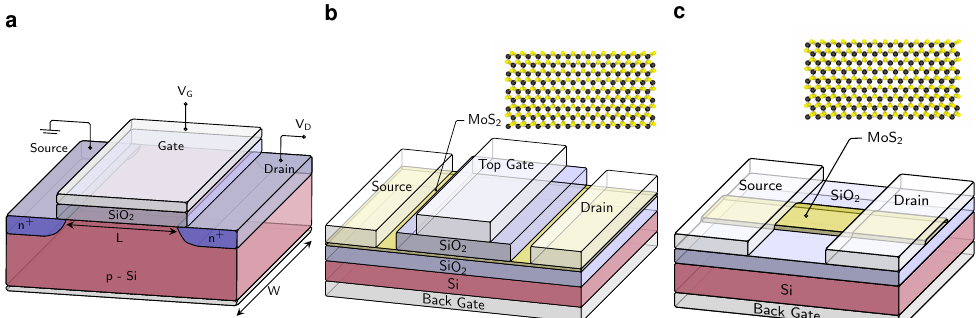
Figure 1. ( a ) Schematic drawing of a planar n-type silicon MOSFET. ( b ) Schematic layout of a large area FET with an MoS 2 channel. Here, SiO 2 is the back gate oxide with Si serving as the global back gate and the top gate oxide with a local top gate contact. This double-gated configuration provides the best gate control. In the upper right corner, the atomic structure of a monolayer of the semiconducting 2H phase of MoS 2 is shown. The black spheres represent Mo atoms and the yellow spheres S atoms. ( c ) Layout of a small area back-gated MoS 2 /SiO 2